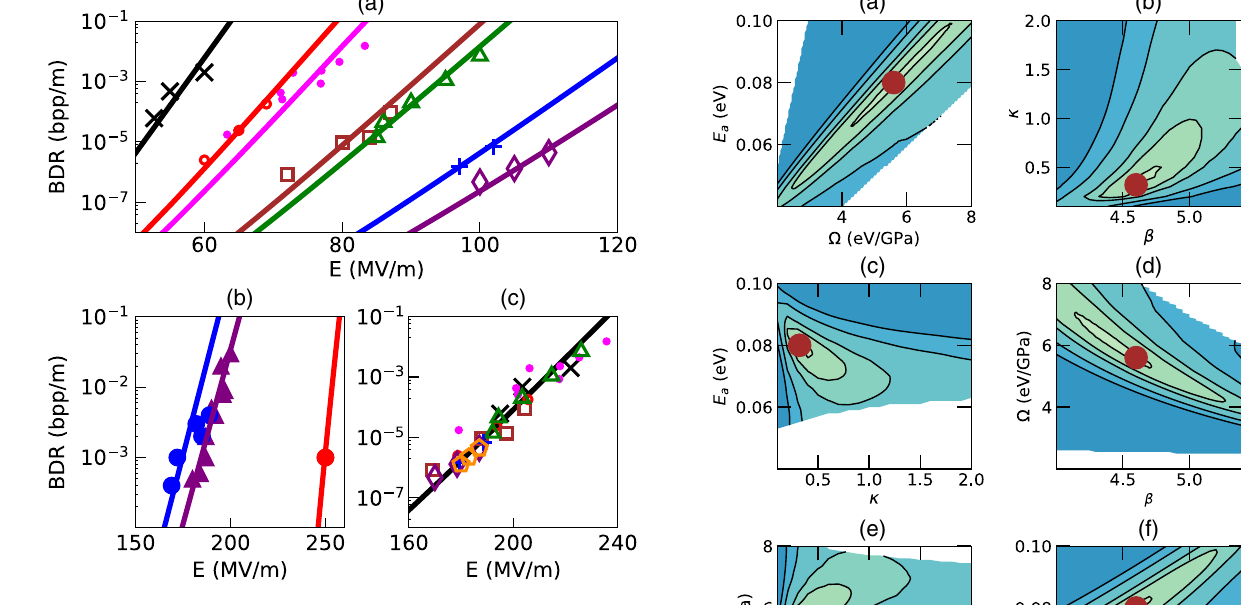
FIG. 8. BDRasafunctionoftheelectricfield:(a)Group(1)inthe text, measured at 300 K in various structures [22]. (b) Group (2) in the text. The two data sets on the left were measured at 300 K, and the set on the right was measured at 45 K [54]. In (a) and (b), the lines represent a fit to the MDDF model with the nominal set of parameters, except for β , which varies among the data sets. (c) Group (3) in the text represented by the yellow pentagons [55],andgroup(1),withtheelectricfieldsscaled,representedbyall other symbols. The line in (c) represents a fit to the MDDF model with the nominal set of parameters (including β ).